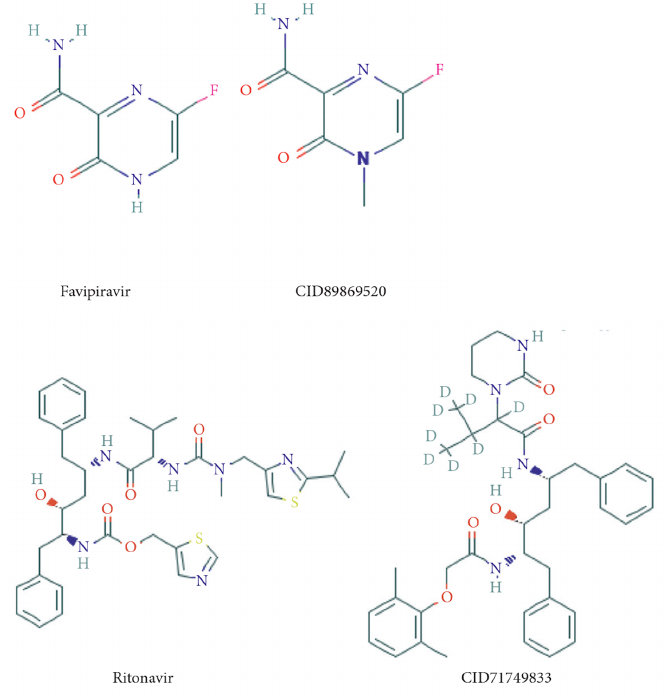
Figure 3. Chemical structures of favipiravir, ritonavir, and their